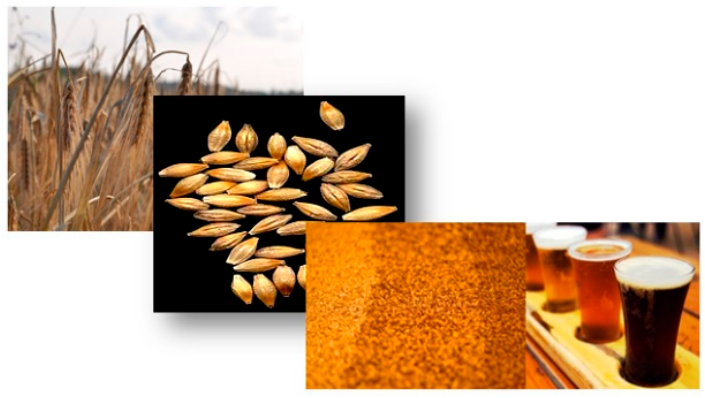
Figure 1. Beer production (own source).